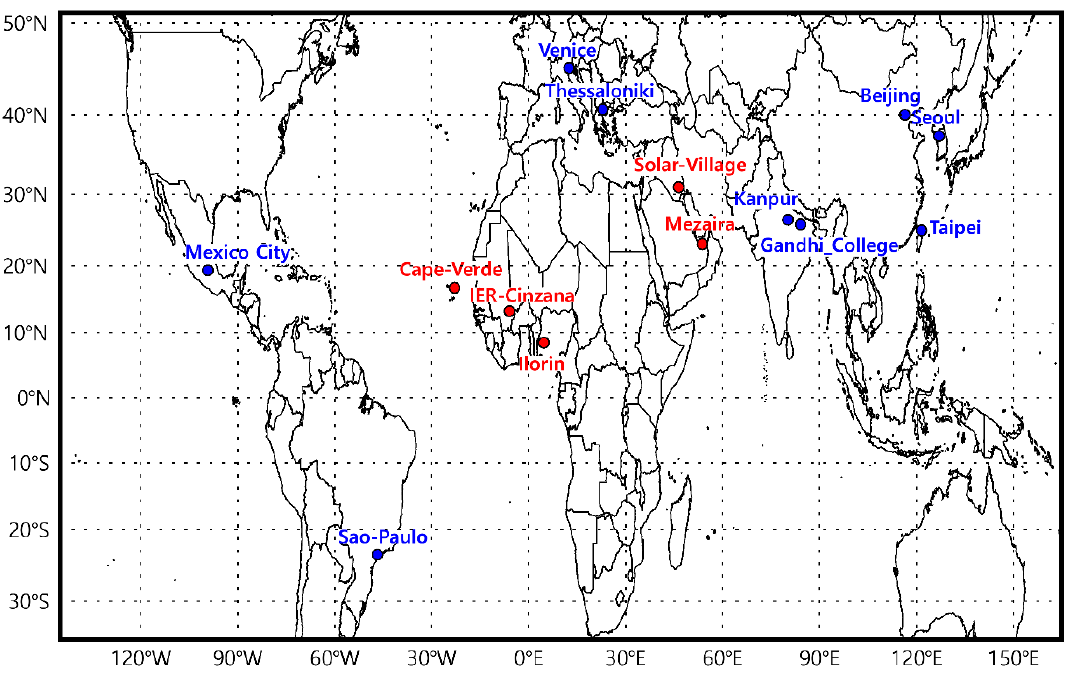
Figure 1. Locations of the selected AERONET sites (red color represents the sites with dust-dominant AAOD and blue color represents the sites with non-dust-dominant AAOD).